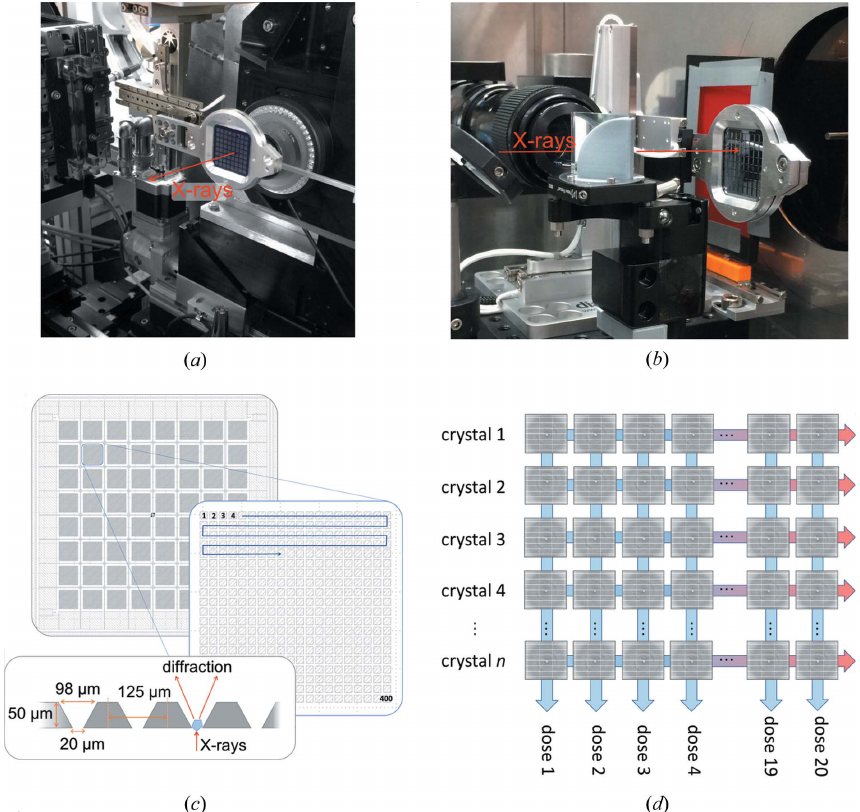
Figure 1 Fixed-target instrumentation in place at ( a ) beamline I24, Diamond Light Source and ( b ) beamline BL2 EH3, SACLA. ( c ) Schematic of fixed target used showing layout of 8 (cid:5) 8 ‘city blocks’, each comprising 20 (cid:5) 20 apertures. Shown is a zoomed-in view of a single city block with motion path followed and chip cross-section. ( d ) Formation of dose-resolved datasets by collecting multiple images at each chip aperture. For XFEL data collection, only a single dose point is recorded at each